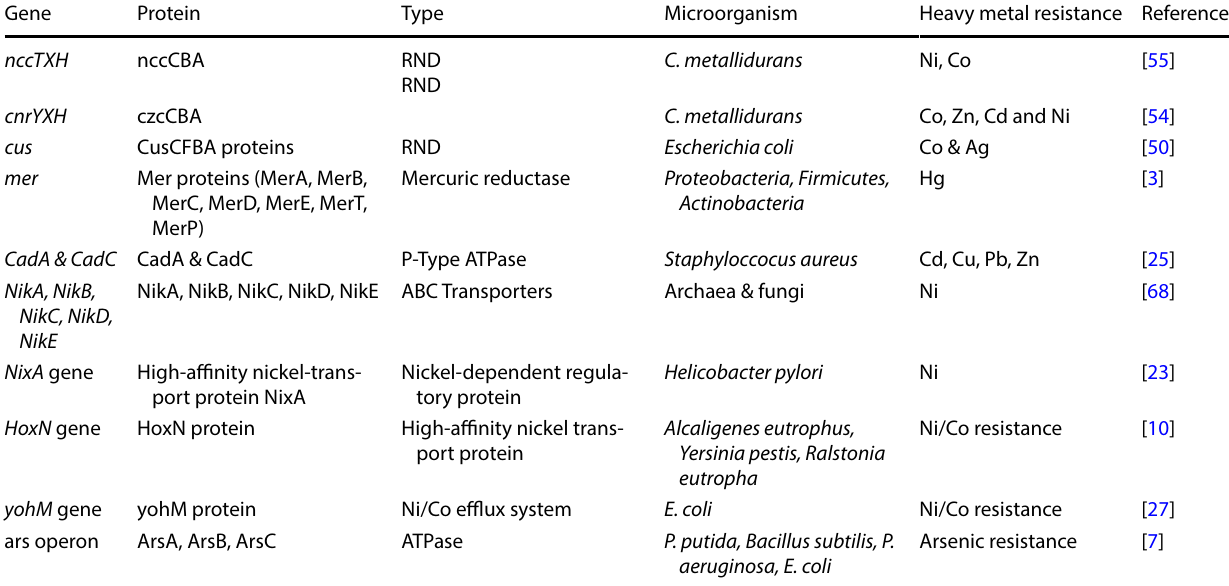
OMF , Outer membrane factors, MFP , membrane fusion protein family, RND , resistance, nodulation, and cell Table 4 Examples of genes and proteins that provide heavy metal resistance to